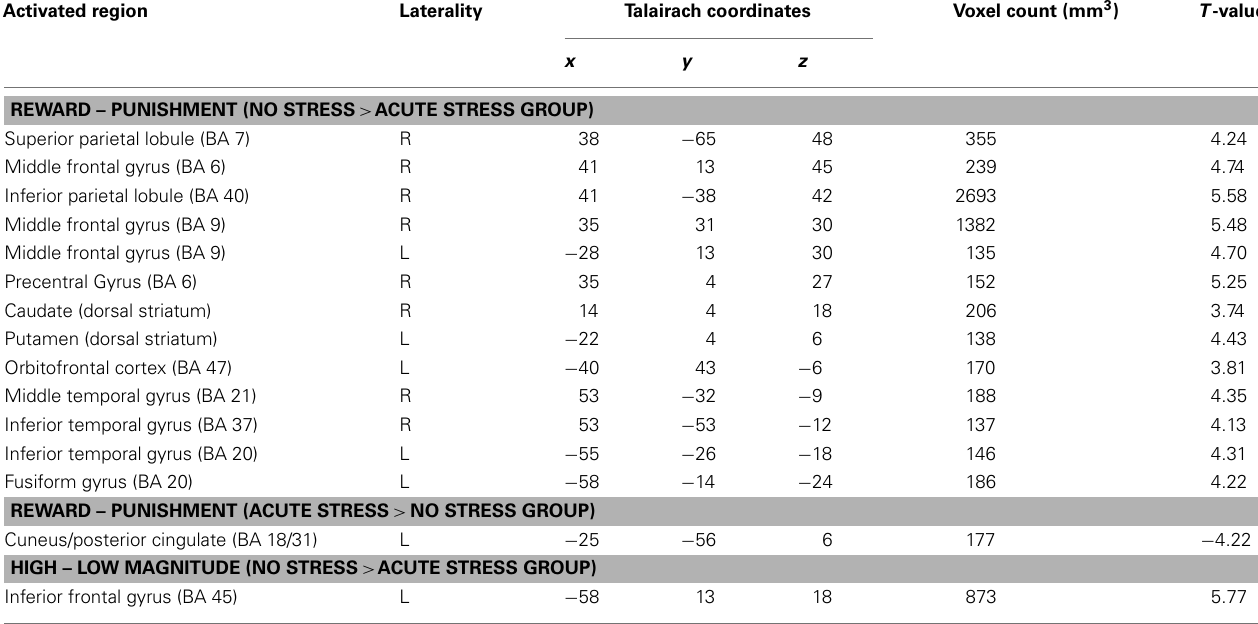
Table 2 | Brain regions that demonstrated differences by experimental group (No Stress vs.Acute Stress) for Reward – Punishment and High – Low Magnitude contrasts ( p < 0.005,